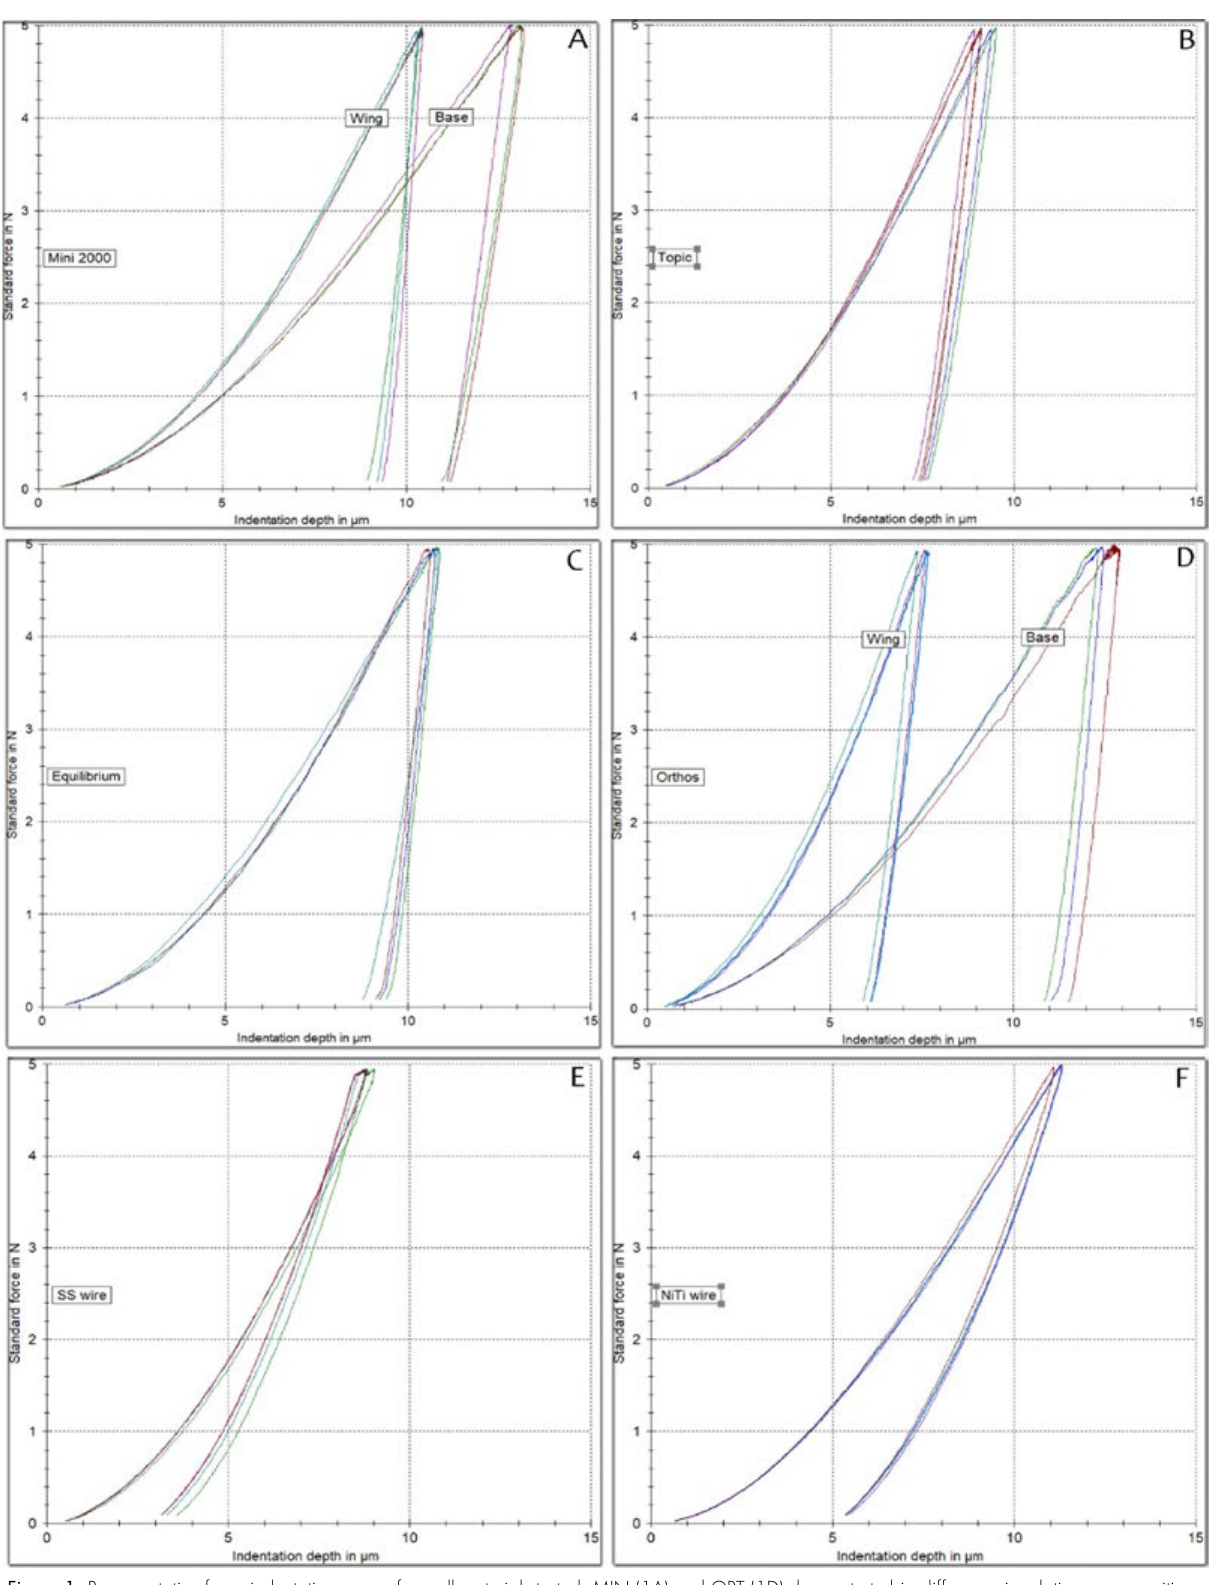
Figure 1. Representative force indentation curves from all materials tested. MIN (1A) and ORT (1D) demonstrate big difference in relative curve position for base and wing regions while TOP (1B) and EQU (1C) provide almost identical curves from both regions. The curves of SS (1E) and NiTi wire (1F) are also